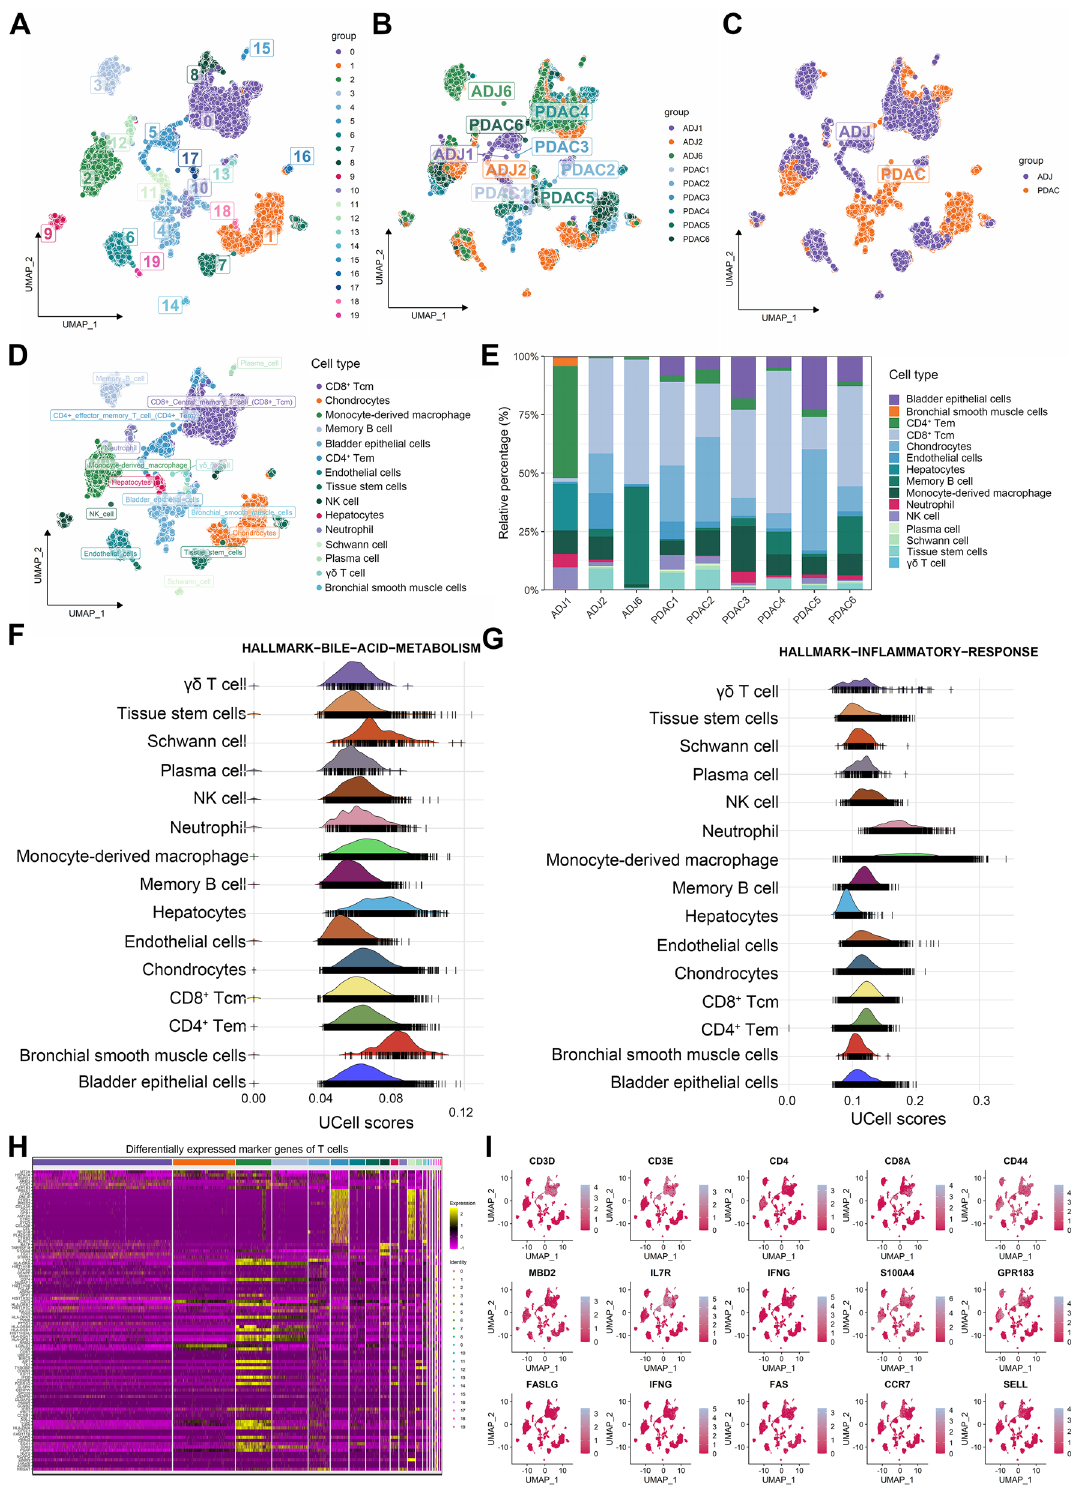
Figure 2. scRNA- seq analysis to identify different cell populations in the TME of PDAC and adjacent samples. ( A–D ) UMAP was adopted to identify different clusters ( A–C ) and cell types ( D ) between PDAC and adjacent samples. ( E ) The proportion of different cell types in each sample. ( F–G ) the single-cell GSEA exhibited that all cells were significantly involved in bile acid metabolism ( F ) and inflammation response ( G ) related pathways. ( H ) Heatmap to display the expression pattern of TMGs in different clusters. ( I ) dimensionality reduction plot to show the specific markers genes of CD8 + Tcm, CD4 + Tem, and γδT cells. scRNA- seq , single-cell RNA sequencing; TME, tumor immune environment; PDAC, pancreatic ductal adenocarcinoma; UMAP, uniform manifold approximation and projection; GSEA, gene set enrichment analysis; TMGs, T cell marker genes; TCGA; The Cancer Genome Atlas; TMGS, T cell marker genes score; Tcm, central memory T cell; Tem, effector memory T